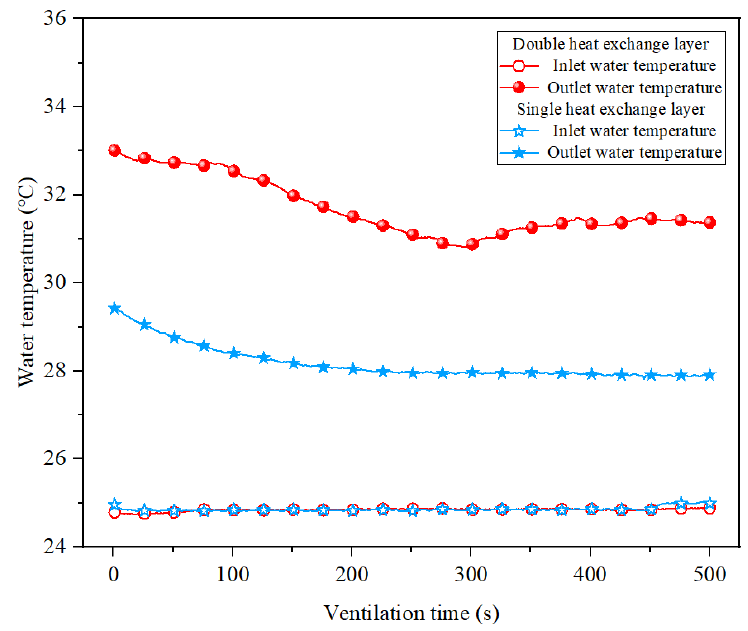
Figure 13. Variation of inlet outlet water temperature under different heat exchange layer cases.